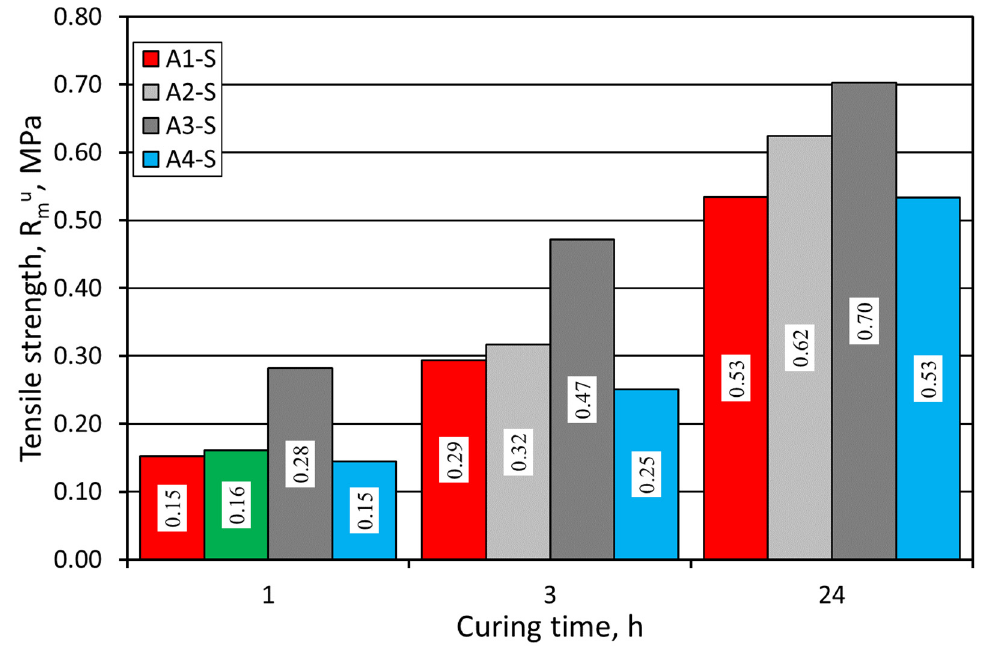
Figure 4. Molding sand R um tensile strength test carried out on SIBELCO (S) grain matrix.